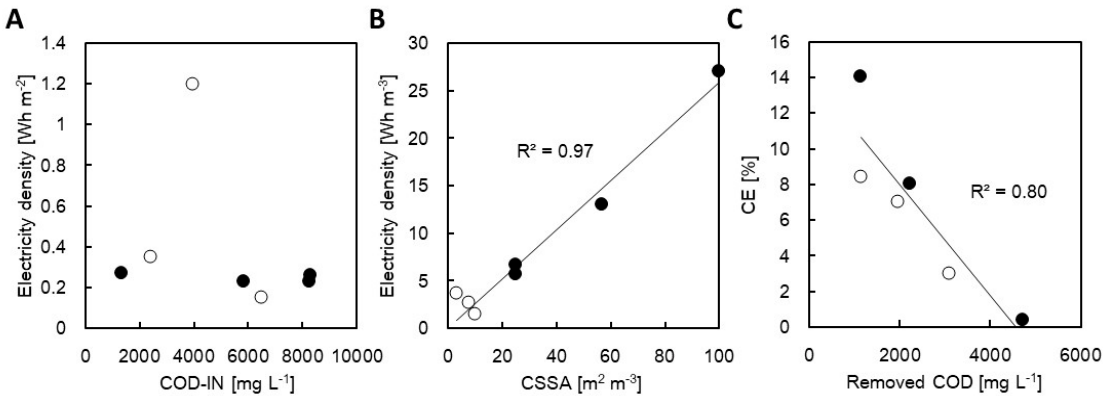
Figure 5. The effects of ( A ) chemical oxygen demand in the influent (COD-IN) and ( B ) specific cathode area on electricity density, and the effect of ( C ) removed COD on Coulombic efficiency (CE). Open and closed circles are the data obtained in this study and previous studies [17,36,38,39], respectively.